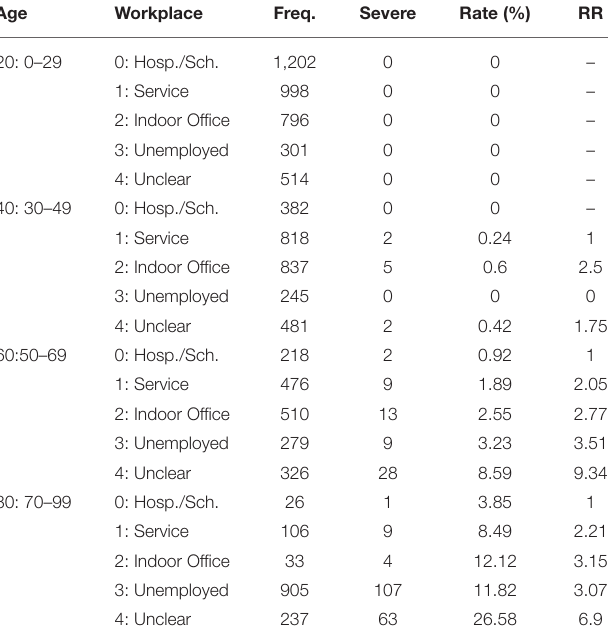
TABLE 6 | The risk for workplace stratified by age. Age Workplace Freq.